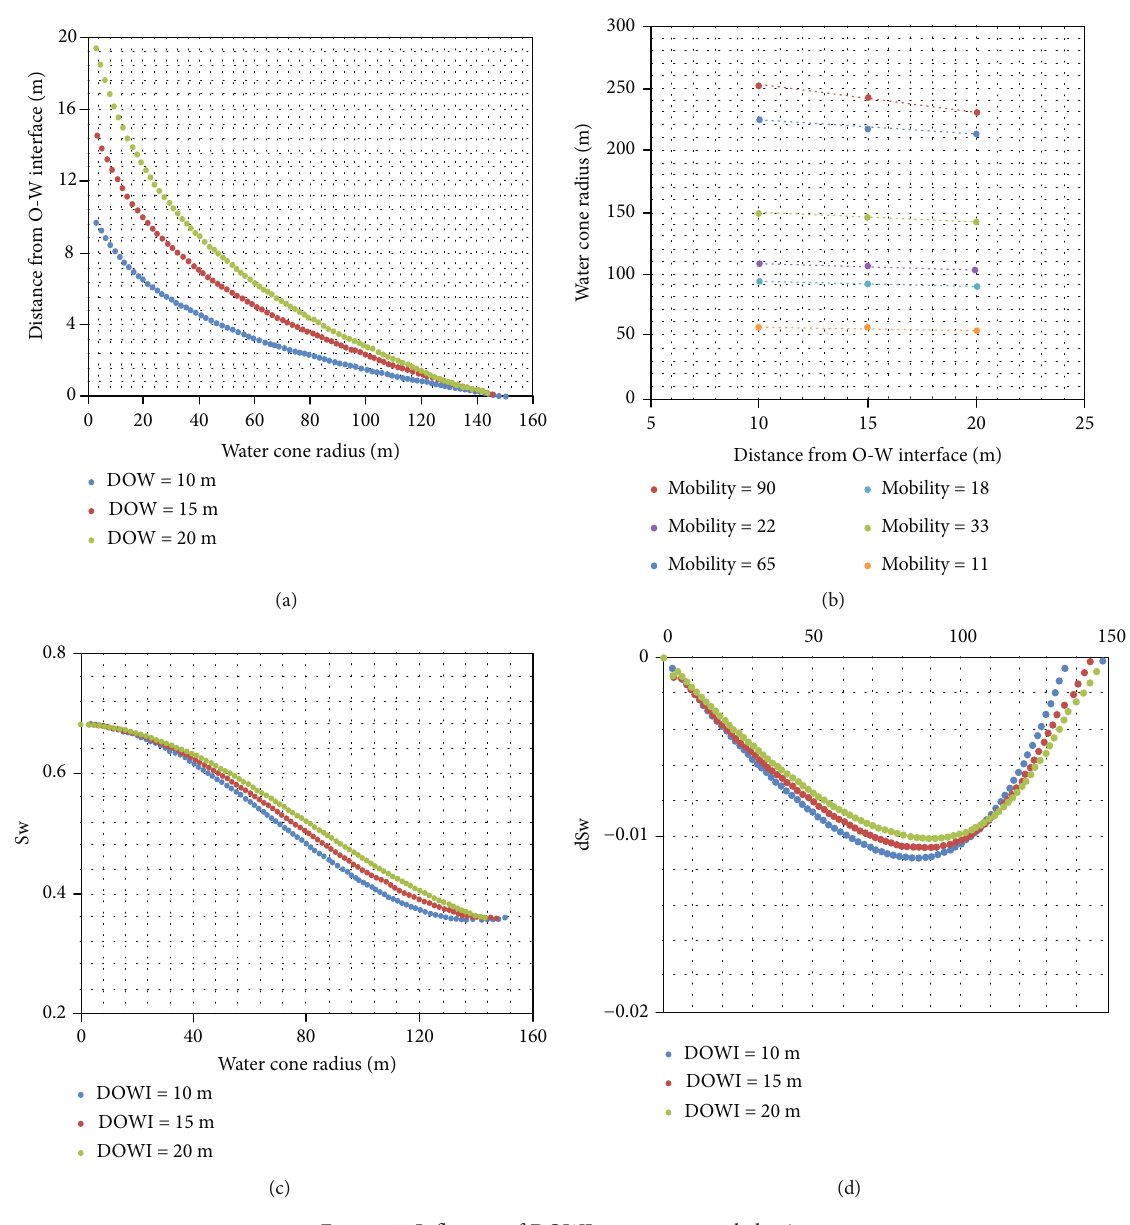
Figure 7: In fl uence of DOWI on water cone